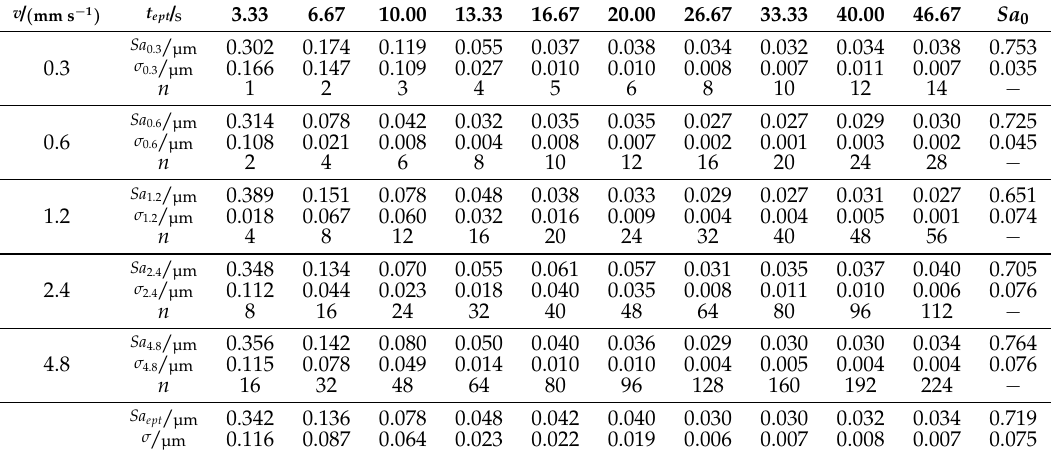
Table 1. Average surface roughnesses Sa v of the pipe inner surface depending on the selected velocity v and number n of plasma polishing passages. The results are listed in columns for a sequence of effective polishing times t ept . The initial average surface roughness Sa 0 is given in the last column. The last row presents the mean value Sa ept of all above listed values Sa v for the particular effective polishing times t ept